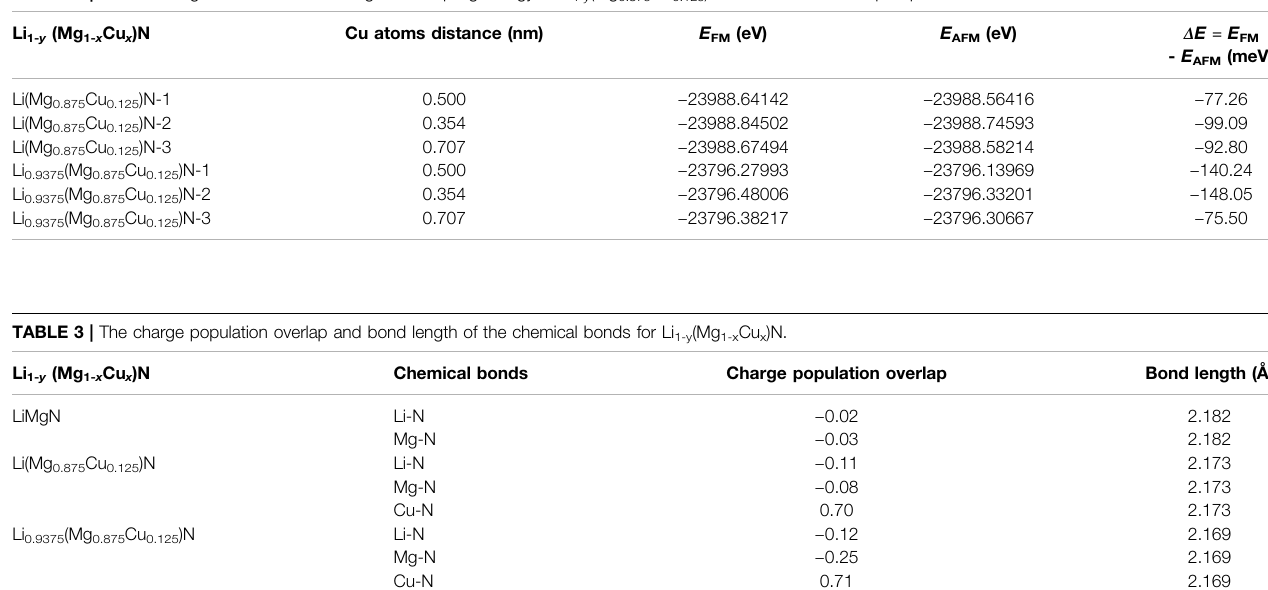
Frontiers in Materials |